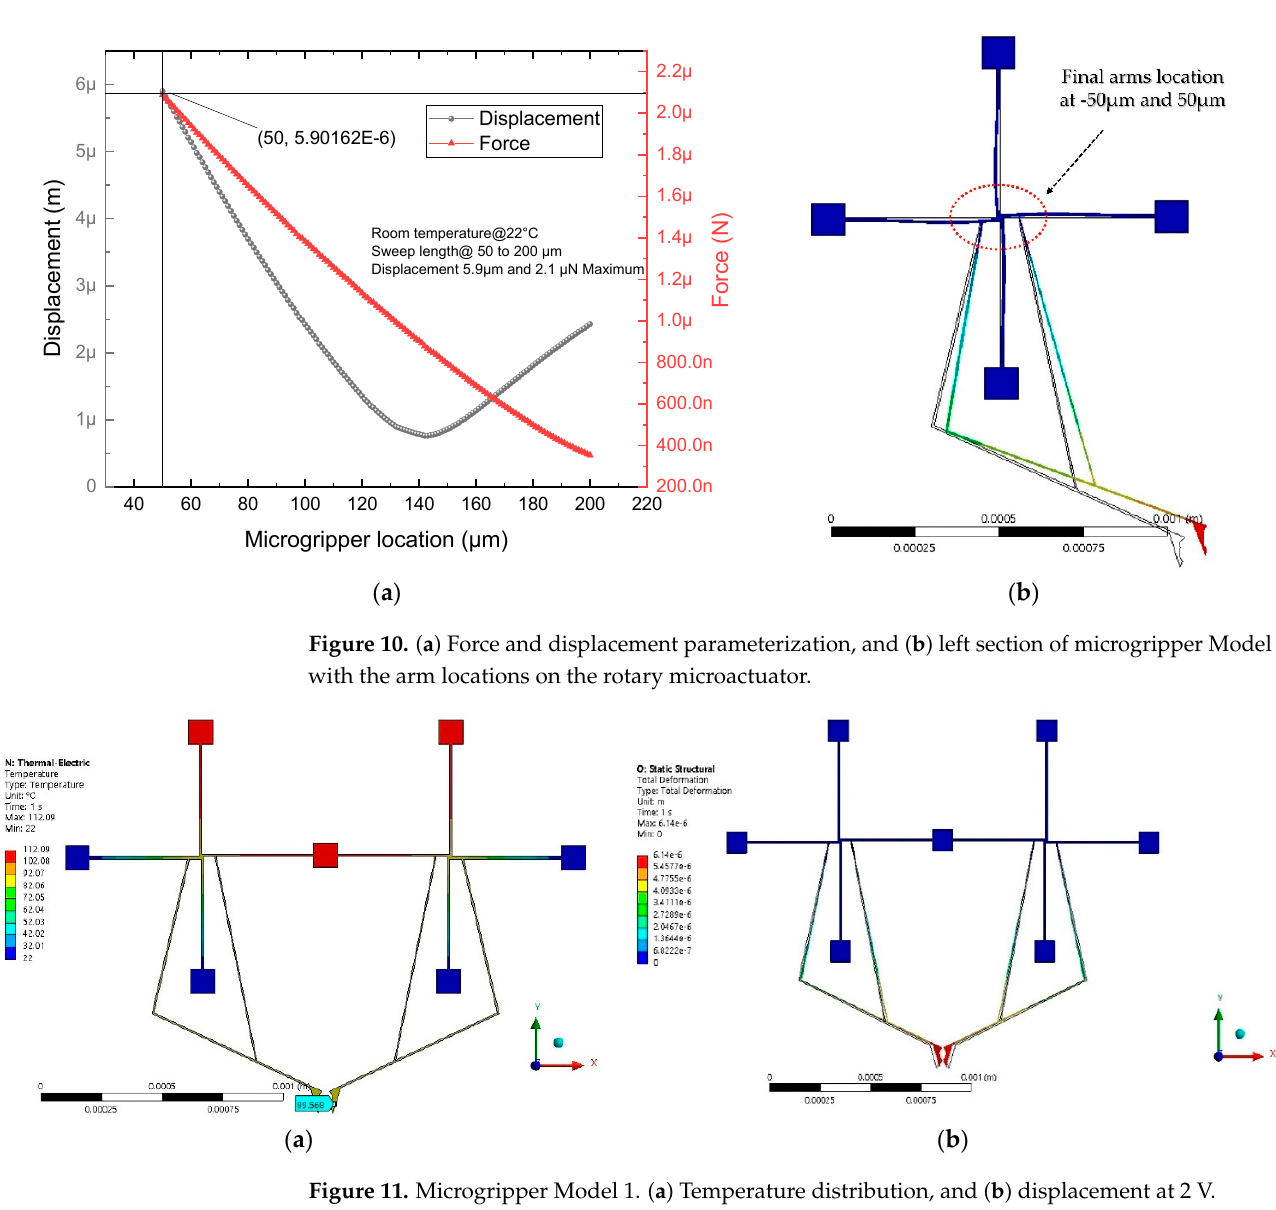
Figure 11. Microgripper Model 1. ( a ) Temperature distribution, and ( b ) displacement at 2 V. Table 7. Parameters values for microgripper Model 1 at 2